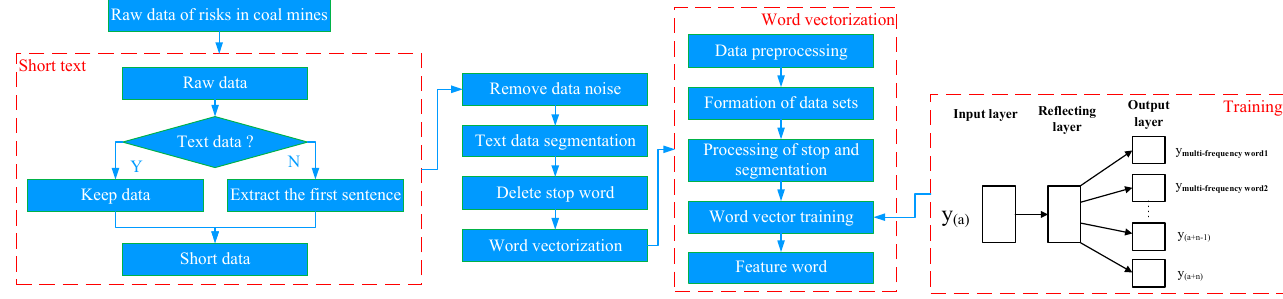
Figure 2. Pre-processing method of mine risk data information.